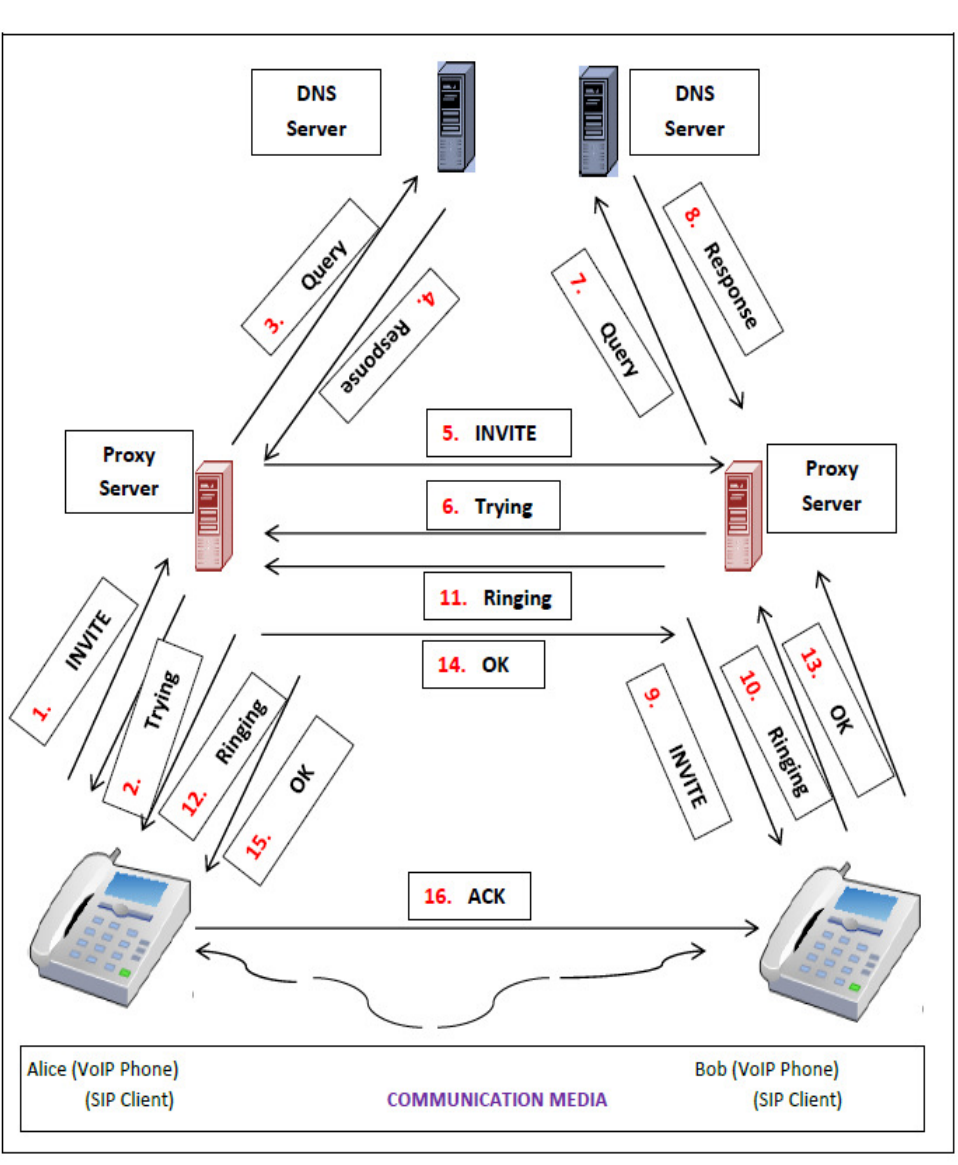
FIG. 3. WORKING SCENARIO FOR SIP CALLER